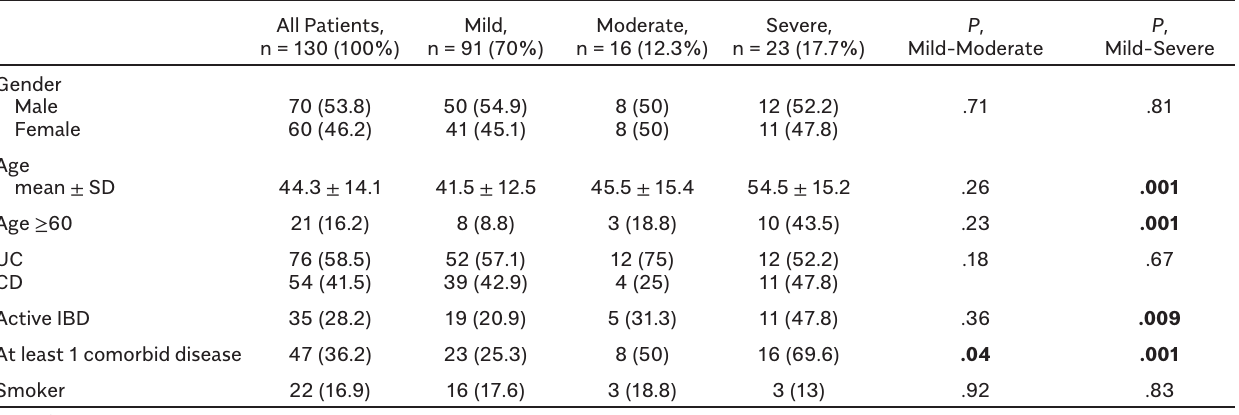
IBD, inflammatory bowel disease. The bold numbers are statistically significant